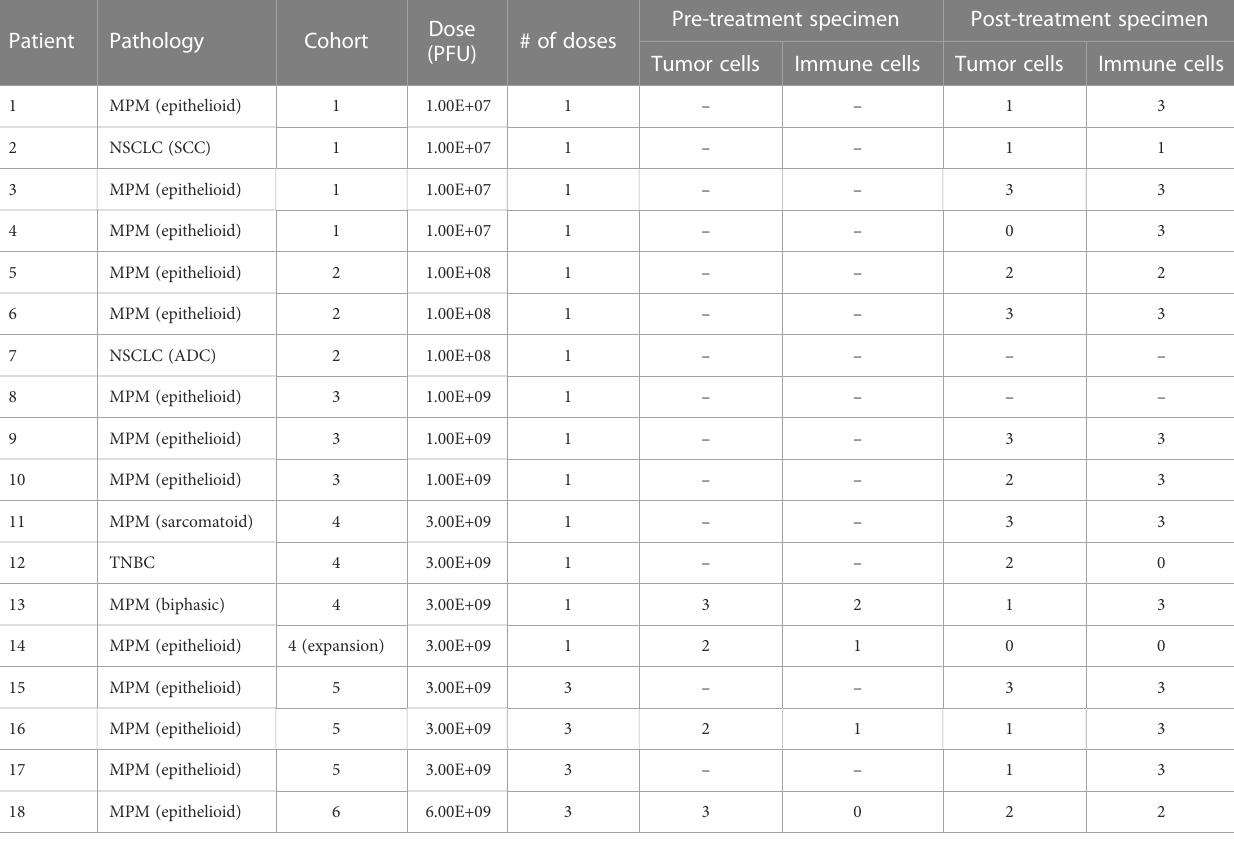
TABLE 3 Tumor and immune cell scoring of tumor specimens stained with hematoxylin and